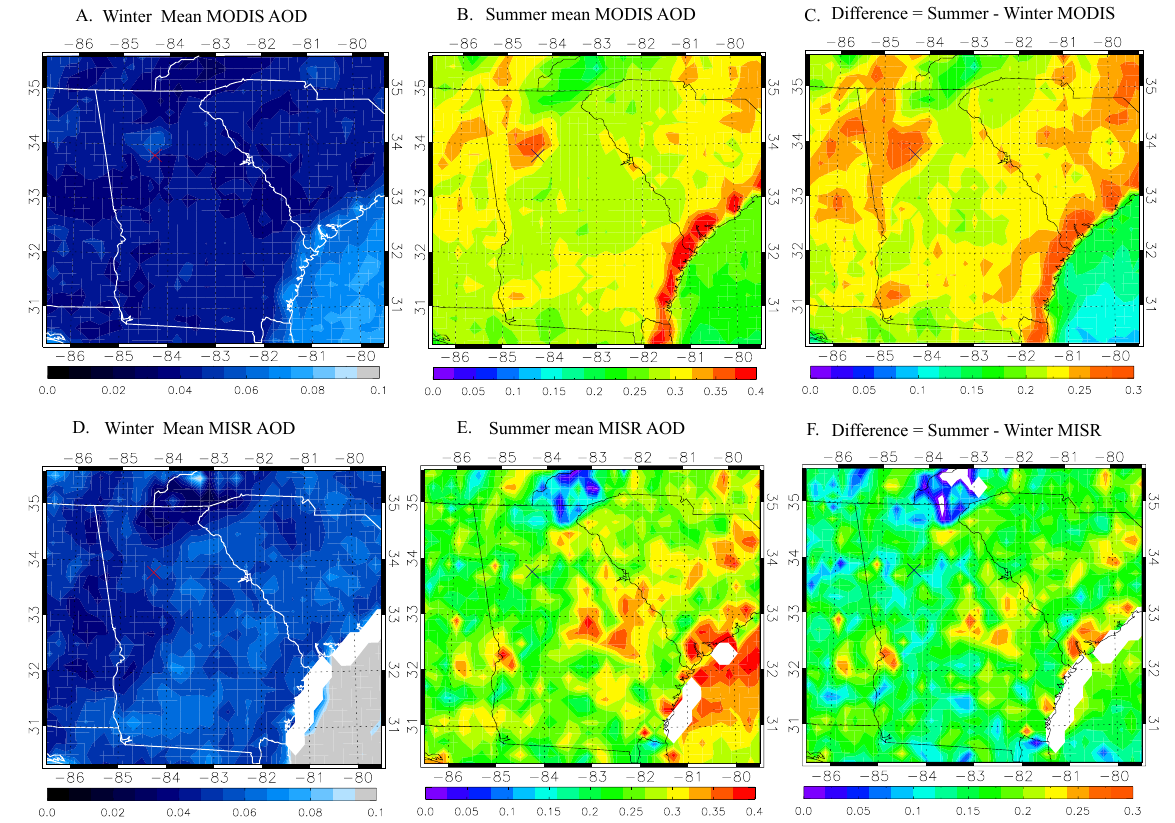
Fig. 6. Maps of satellite AOD. (A) Winter mean AOD for MODIS Terra. (B) Summer mean AOD for MODIS Terra. (C) Difference between summer mean AOD minus winter mean AOD for MODIS Terra. (D) Same as (A) except for MISR Terra. (E) Same as (B) except for MISR Terra. (F) Same as (C) except for MISR Terra. In ( A and D ) the red “X” denotes Atlanta, GA. In ( B–C and E–F ) the navy “X” denotes Atlanta,